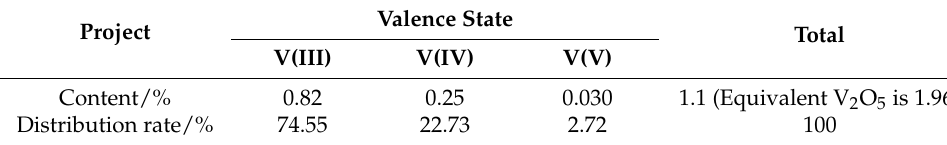
Table 5. Valence distribution of original samples.